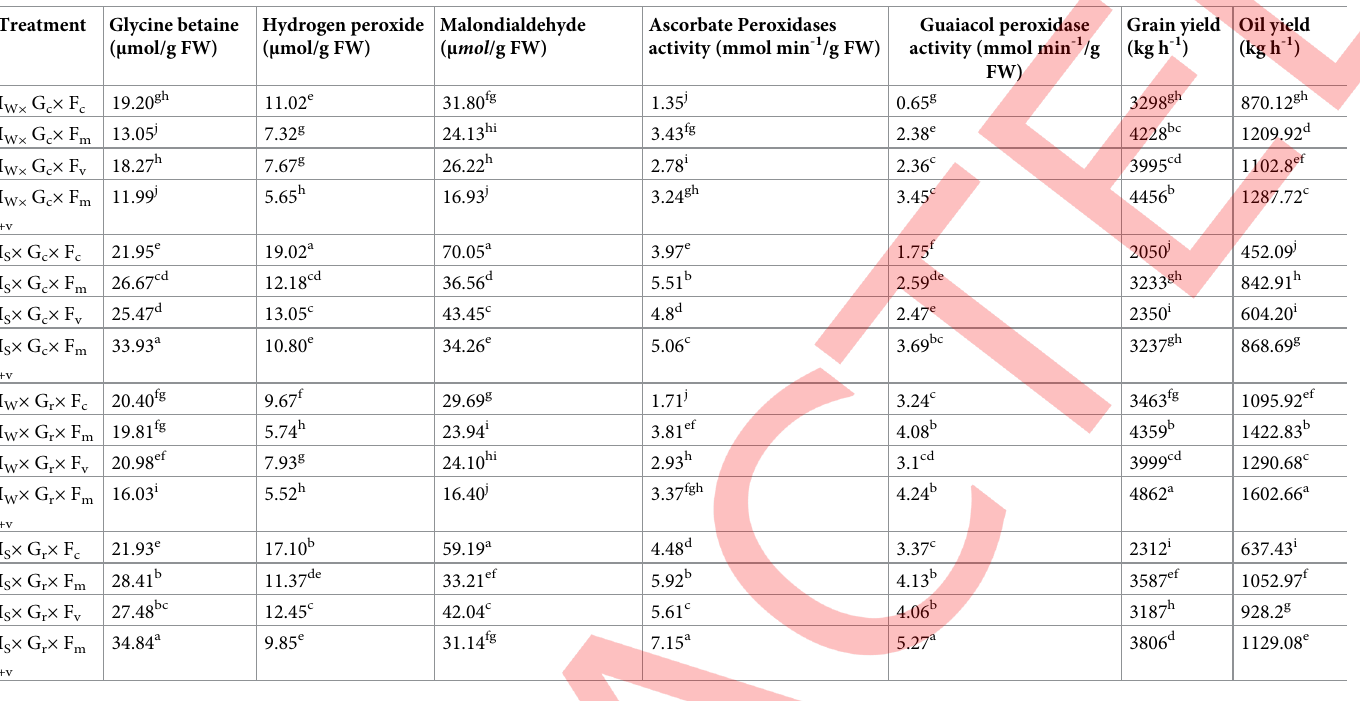
Table 5. Comparison between 2-year mean values of physiological traits of lingrain affected by green manure × mycorrhiza × vermicompost under full and limited irrigation. Treatment Glycine betaine ( μ mol/g